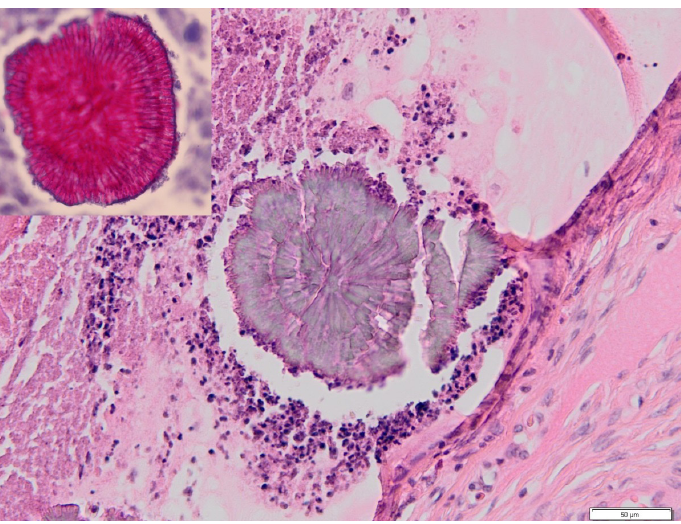
Fig. 1. A pseudoactinomytic granule in a pool of mucus is surrounded by leukocytes and cellular debris (HE, ×400). Inset: At high magnification (x1000), distinct radiate pattern of a PAMRAG is evident.